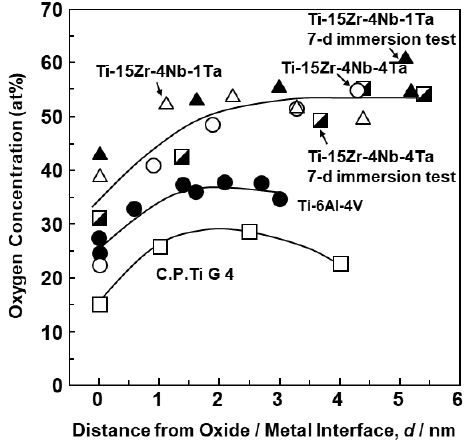
Figure 6. Changes in oxygen (O) concentration (at%) in oxide films formed on Ti–15Zr–4Nb–4Ta, Ti–15Zr–4Nb–1Ta, Ti–6Al–4V, and C.P.-Ti grade 4 surfaces by anodic polarization up to 0 mV vs. SCE or in 7-d immersion test for Ti–15Zr–4Nb–1Ta and Ti–15Zr–4Nb–4Ta alloys in 0.9% NaCl at 37 °C.